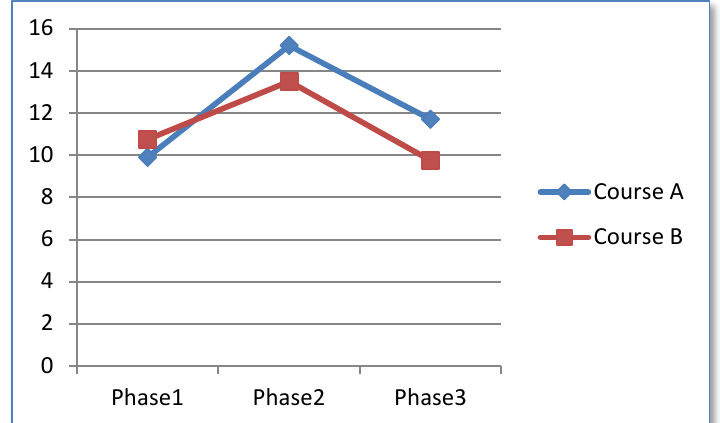
Figure 9. Average attendance for each phase for the two